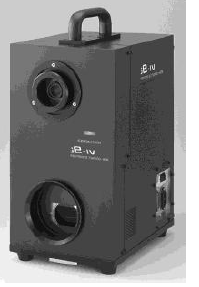
Figure 3. Close range scanner VIVID 9i